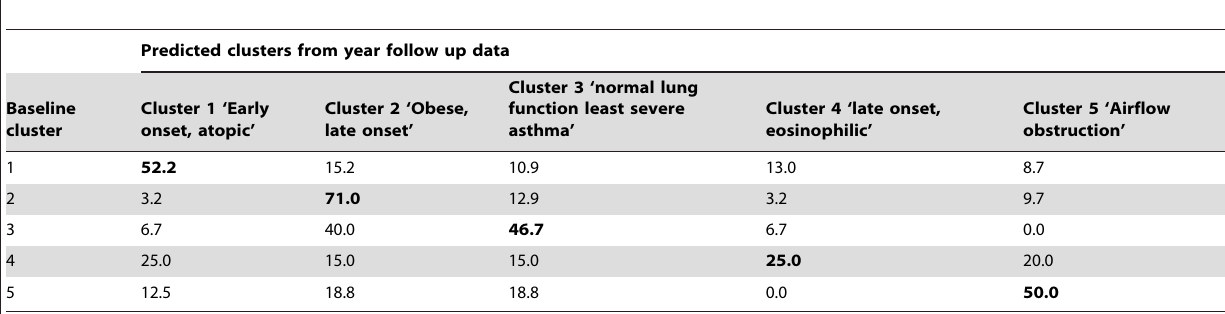
Table 5. Cluster memberships at baseline compared to classification membership at follow up.